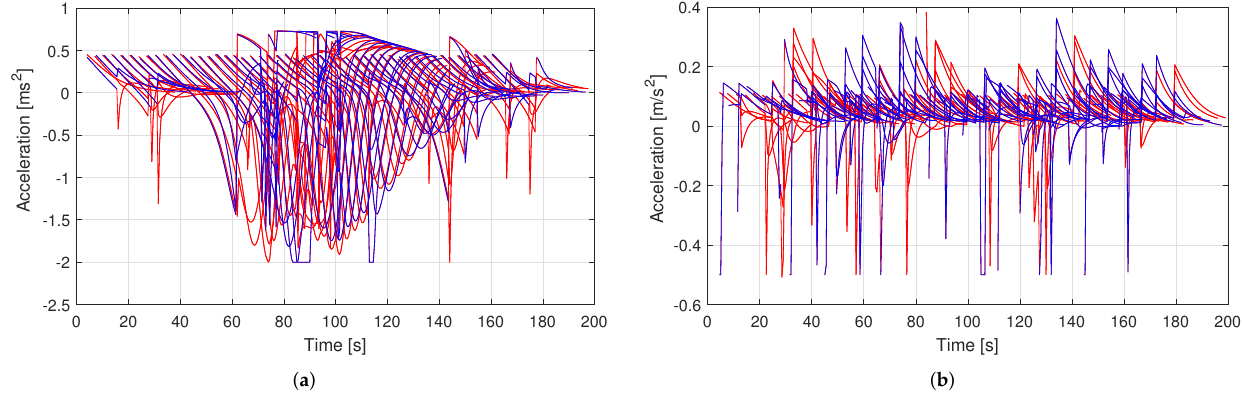
Figure 7. Acceleration profiles of the vehicles showing the level of aggressiveness for ( a ) the tradi- tional driving system and ( b ) the proposed traffic coordination system.